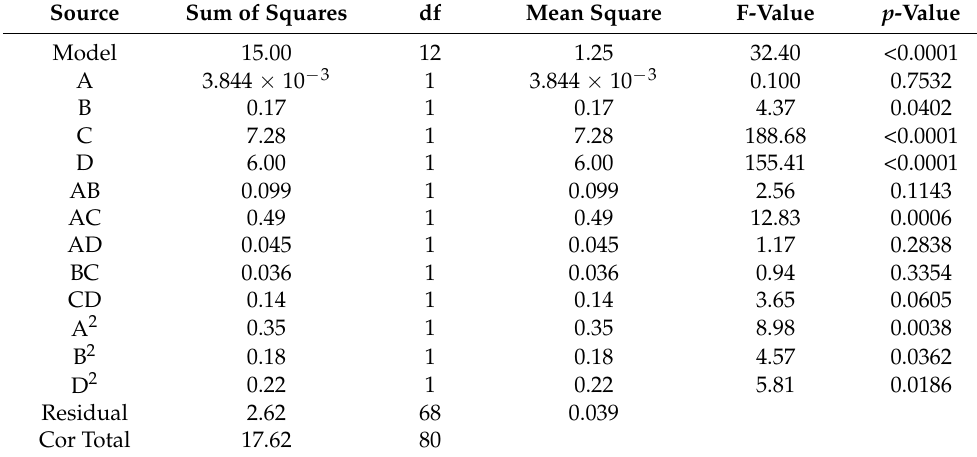
Table 3. ANOVA for response surface quadratic of compressive strength